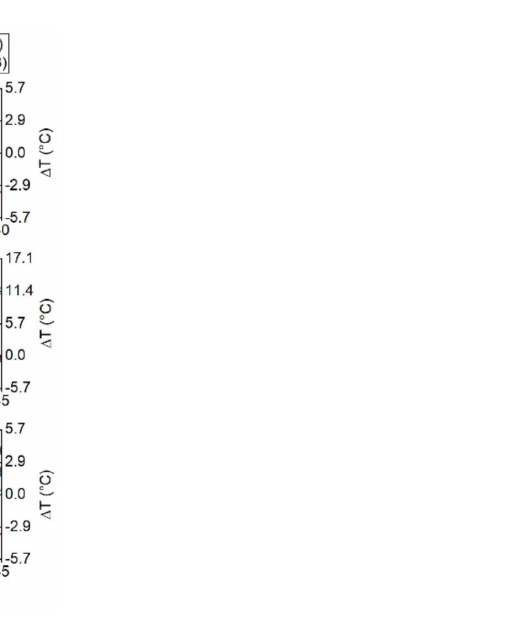
Figure 15. Wavelength drift of SCF gratings at 1000 ◦ C, 1050 ◦ C and 1100 ◦ C (reproduced from